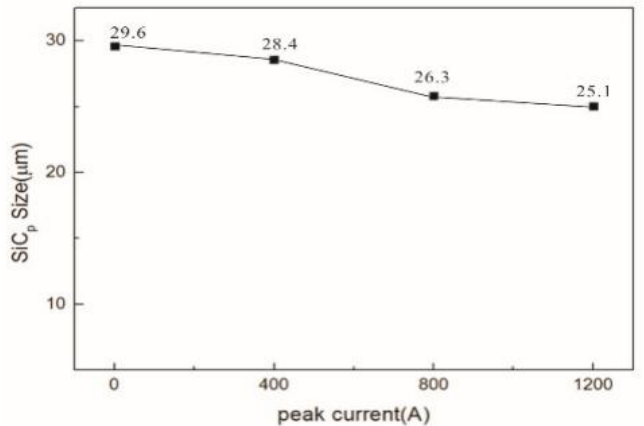
Figure 6. Average grain size of SiC under different pulse current conditions.